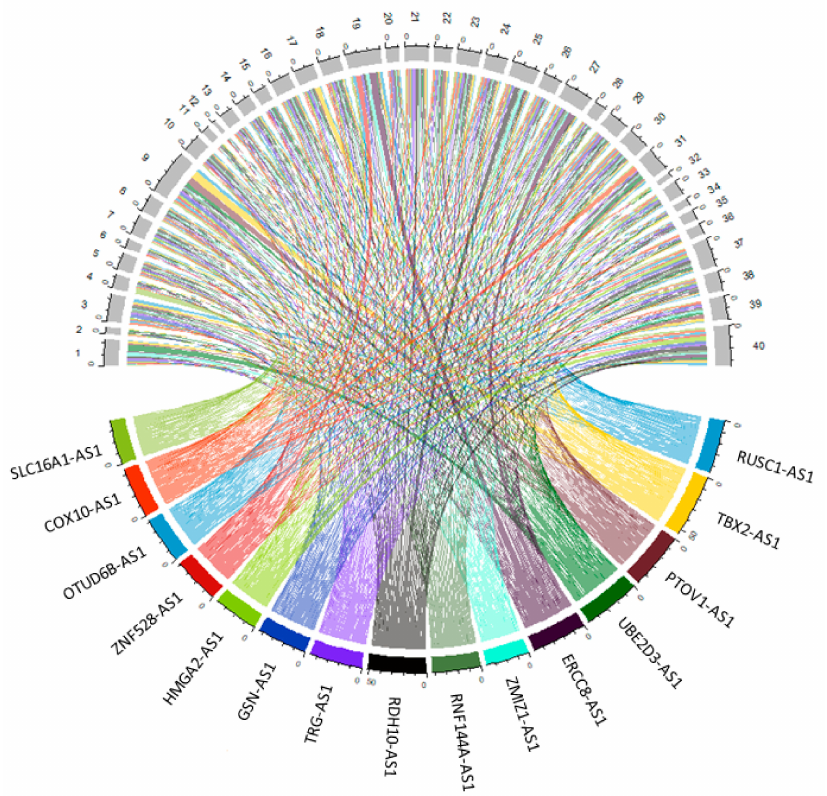
Figure 4. Circos plot visualizes the antisense lncRNAs expression in individual samples. 1, 3, 5, 7, 9, 11, 13, 15, 17, 19, 21, 23, 25, 27, 29, 31, 33, 34, 35, 36, 37, 38, 39, 40 are tumour samples, whereas 2, 4, 6, 8, 10, 12, 14, 16, 18, 20, 22, 24, 26, 28, 30, 32 are normal samples. Each colour represents a